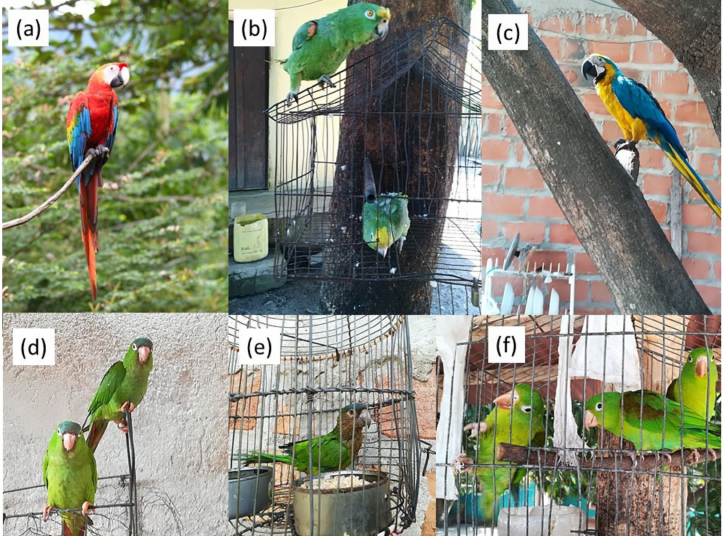
Figure 3. Some pet parrots observed in public spaces such as streets ( a – c ) or within homes ( d – f ). Pictures also illustrate species positively (( a ): scarlet macaw Ara macao , ( b ) yellow-crowned amazon Amazona ochrocephala , ( c ) blue-and-yellow macaw Ara ararauna , ( d ) blue-crowned parakeet Thectocercus acuticaudatus ) and negatively selected by people as pets (( e ) brown-throated parakeet Eupsittula pertinax , and ( f ) orange-chinned parakeet Brotogeris jugularis ). Pictures: P. Romero-Vidal and J.L.